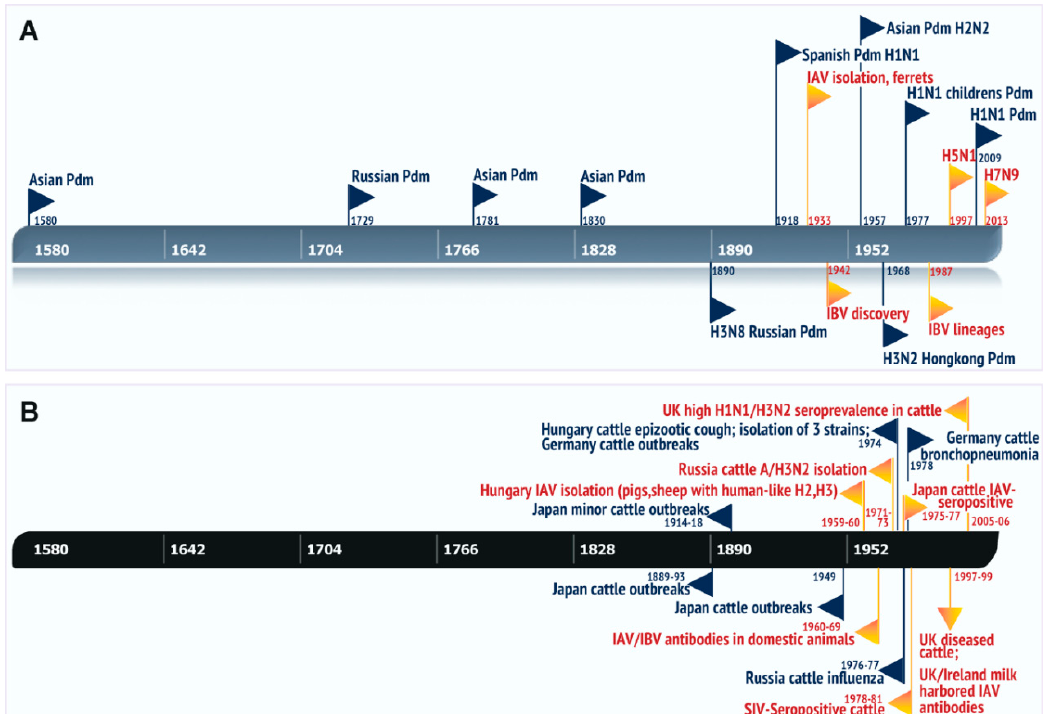
Figure 3. History timeline of the major influenza events in the past ( A ) Known human influenza pandemics along with the important outbreaks / discoveries. All the pandemics with year and country of origin are indicated in “black” flag, black font, while the other outbreaks / epidemics / discoveries are indicated in “orange” flag, red font. ( B ) influenza A incidences occurred in ruminants especially bovine species, were plotted based on the information from peer-reviewed articles. Only the natural infections / outbreaks and seroepidemiological studies reported in cattle in the past were included in the timeline. Experimental studies were excluded in this timeline. Illustrated major events included the major influenza outbreaks, cattle epizootics / respiratory disease with year and country of origin, and are represented by black triangle blocks, black font. Please note that both the timelines (A and B) have same dimensions starting with human pandemic as early as 1580 to 2013 H7N9 outbreaks and the timeframe of these cattle outbreaks / diseases (1889, 1893, 1914–1916, 1949, 1959–1960, 1971–1981, 1997–1999, 2005–2006) occurred almost concurrent to the human pandemic / outbreaks, which is indicative of the natural susceptibility of bovines to human influenza viruses. Most of the cattle influenza A isolates appeared to be related to human influenza A strains, with the HA glycoprotein similar to the prototypic human H2 and H3